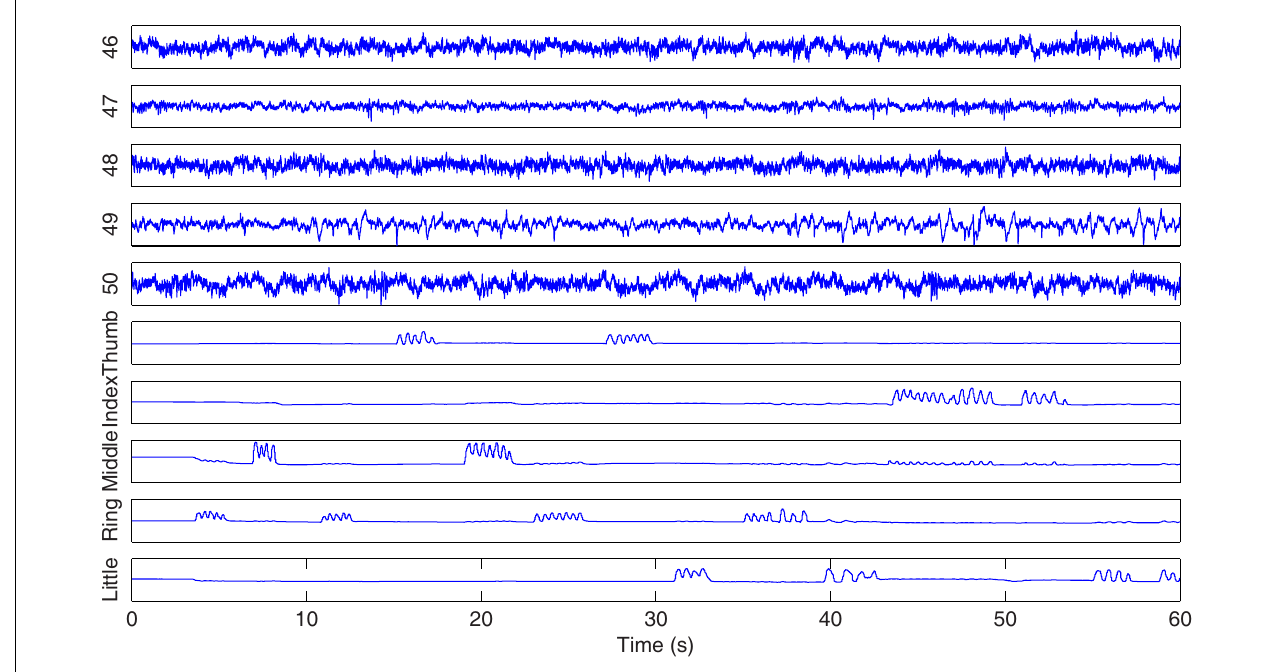
FIGURE 1 | For illustration purposes only, ECoG signals from channel 46 to 50 (at the top) and the corresponding movement time courses for each finger (at the bottom) for the first 60s of the training data set from subject 1 are